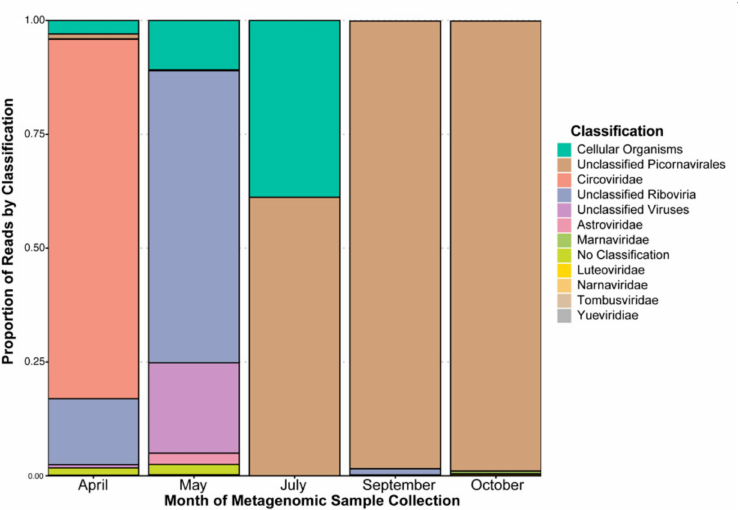
Figure 2. Proportion of normalised reads mapping to each classification by each metagenomic sampling month. Classifications were given to contigs assembled from all samples’ reads that accounted for at least 99% of all reads in each sample by month. These contigs included 26 viral best hits, 12 with no hit, and 496 with a cellular organism top hit. Note: due to the combining of all reads from each sample month for the assembled contigs presented in this figure additional classifications were permitted when compared to Figure